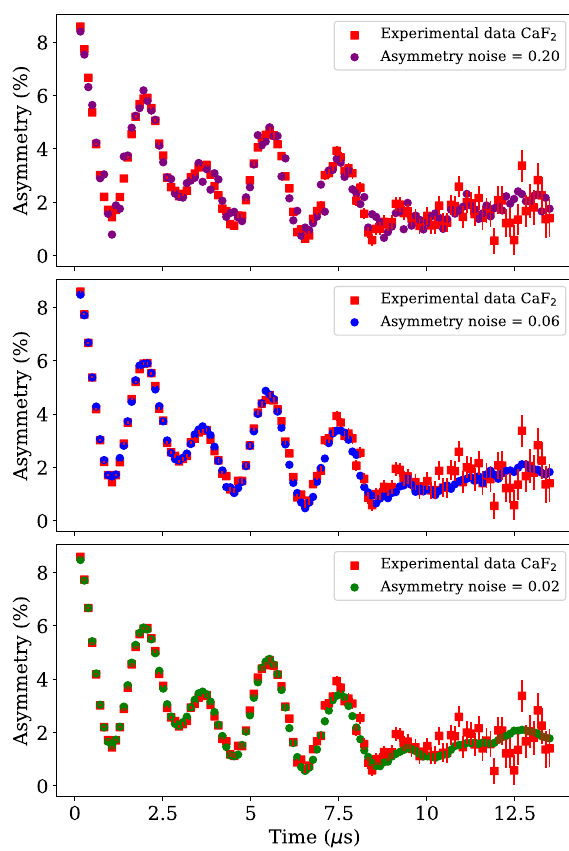
FIG. 14. Fits of the 11-qubit simulated data with 40 second- order Trotter steps to the experimental data obtained in Ref. the muon-fluorine distances described in the main text, and a value to an asymmetry value.